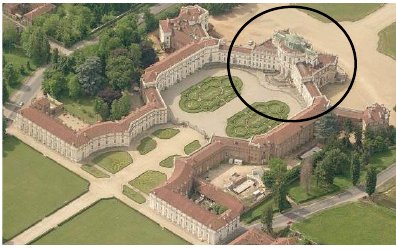
Figure 3. The Stupinigi royal estate (in the circle the royal hall)